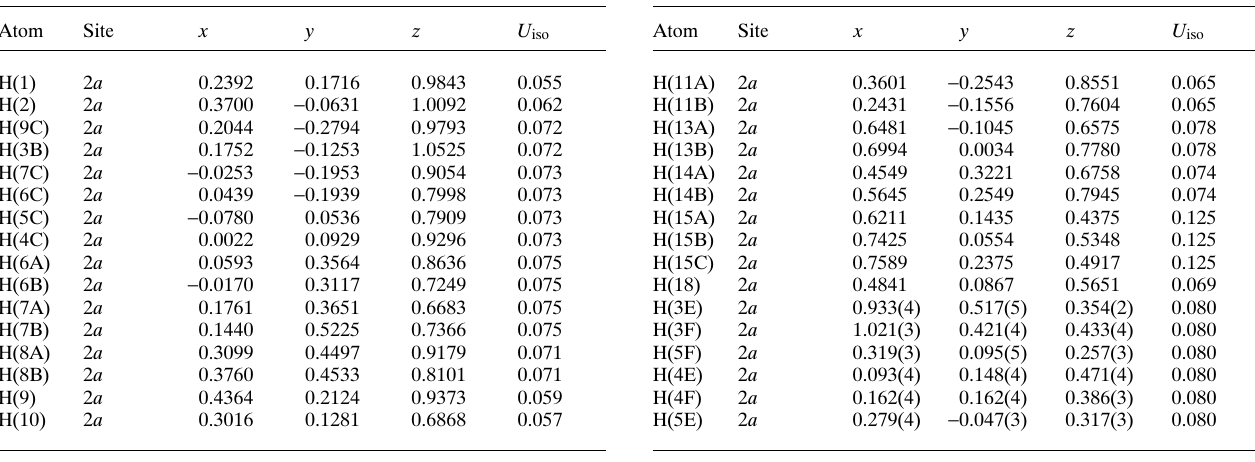
Table 2. Atomic coordinates and displacement parameters (in Å 2 )